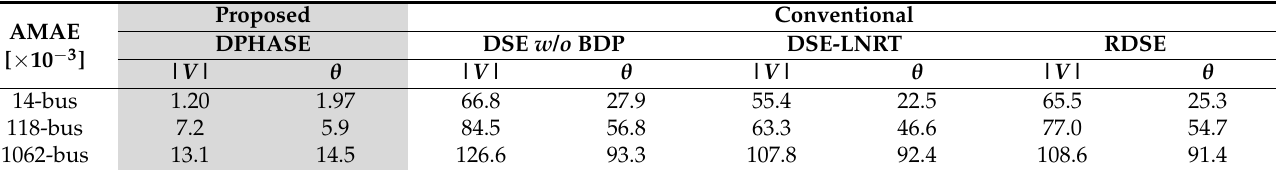
Table 12. Comparison of the AMAEs for the corrupted PMU data.